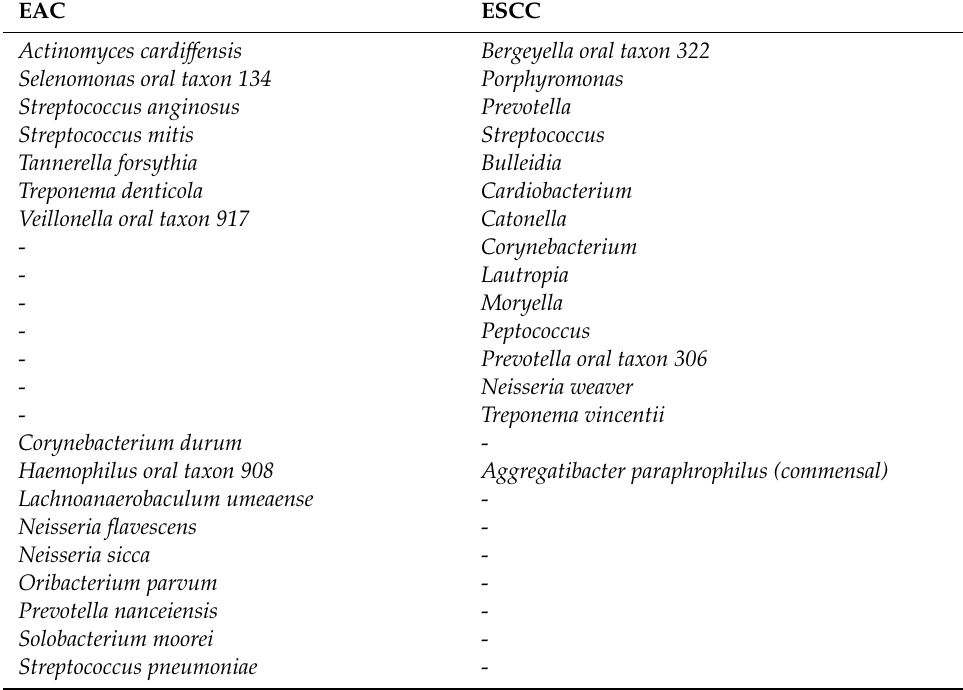
Table 2. Oral microbiota composition di ff erences between esophageal squamous cell carcinoma and esophagus adenocarcinoma (distribution of clones at the genus and species